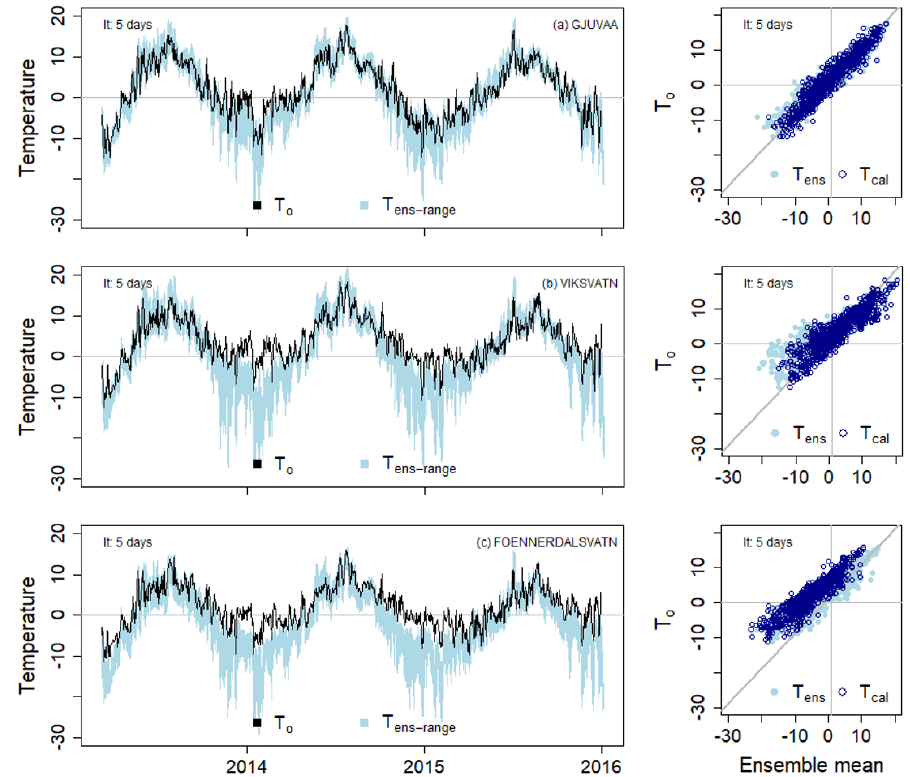
Figure 4. Time series of temperature for Gjuvaa (a) , Viksvatn (b) , and Foennerdalsvatn (c) showing the range of uncalibrated tempera- ture ensemble forecast ( T ens-range , light blue area) for the period 2013–2015; seNorge observations are shown as black lines. Scatter plots show ensemble mean temperature for both calibrated ( T cal , blue) and uncalibrated ( T ens , light blue) temperature plotted against seNorge temperature ( T o ). Lead time (lt) is 5 days.